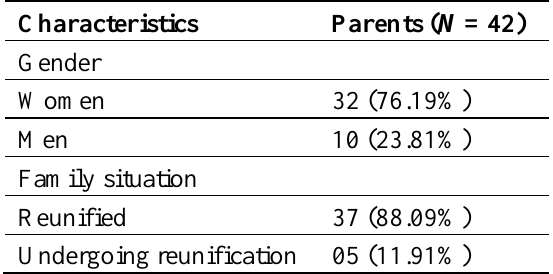
Table 2. Characteristics of the participating parents.